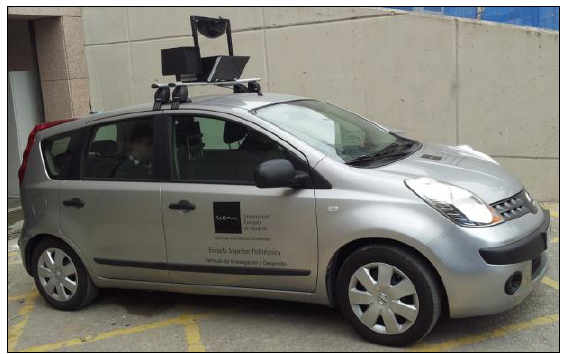
Figure 4. Test vehicle: Nissan Note 1.4 Visia.